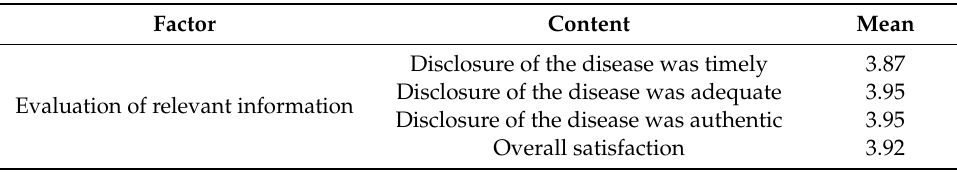
Table 4. Evaluation of COVID-19-related